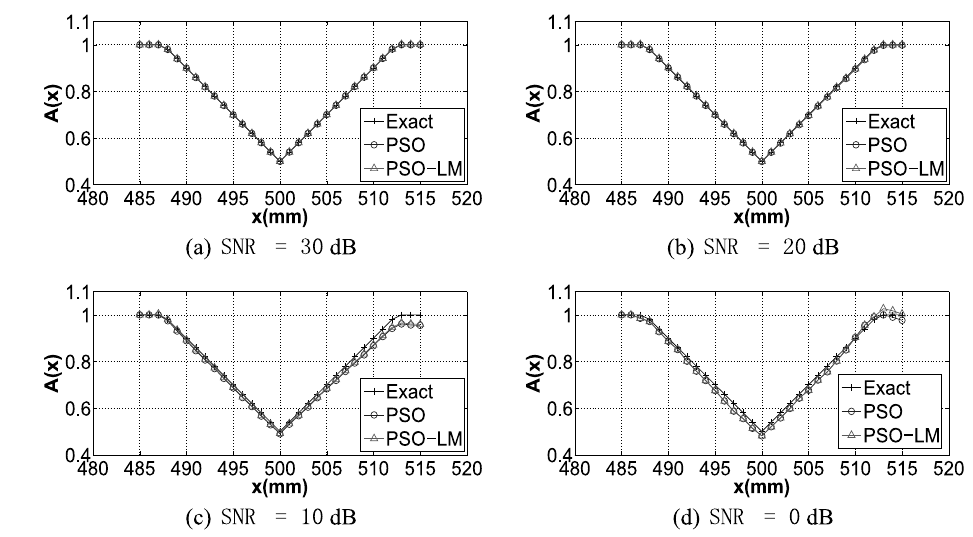
Fig. 10. Damage identi fi cation with four levels of SNR, Case 1, a = 25 mm and d = 5